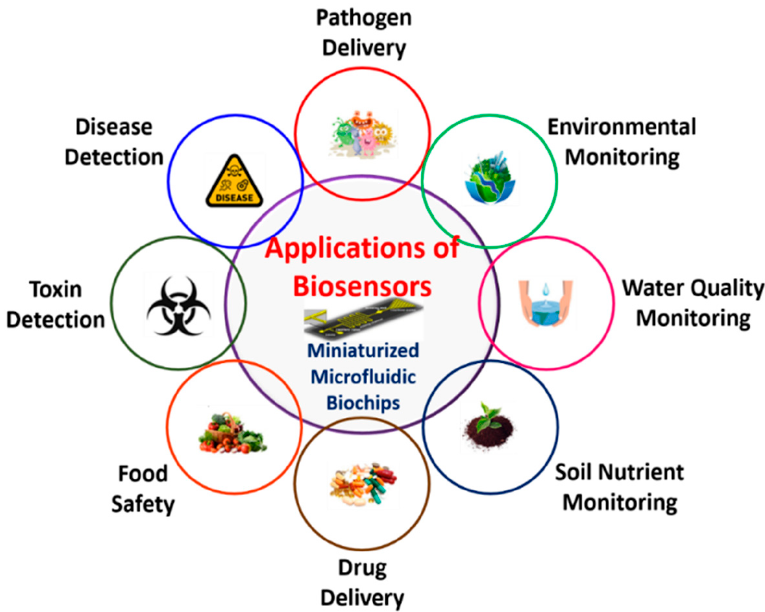
Figure 11. Schematic representation of various applications of biosensors.